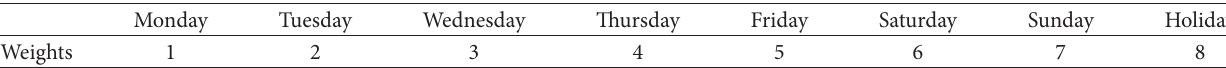
Table 1: The weights of days type.